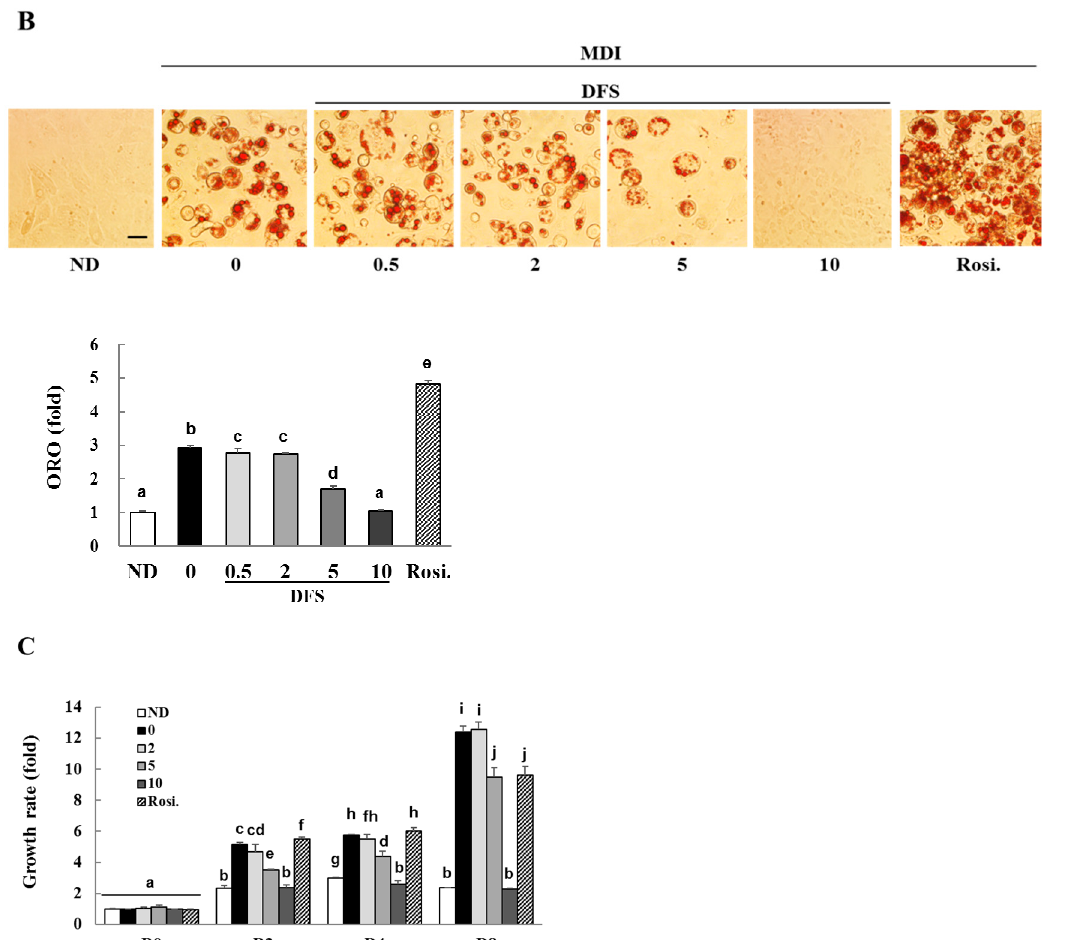
Figure 1. Lignan from A. japonica inhibits adipocyte growth and differentiation. ( A ) Structure of lignan (( − )-(2 R , 3 R )-1,4- O -diferuloylsecoisolariciresinol, DFS). ( B ) 3T3-L1 pre-adipocytes were differentiated with differentiation medium (MDI) in the presence or absence of DFS (0 ~ 10 µM). First, 3T3-L1 cells were stained with Oil Red-O (ORO) on D8 and intracellular lipid contents were quantified and visualized by light microscopy (magnification, ×40). Scale bar = 50 µm. ( C ) MTT assays were performed on differentiation day 0, 2, 4, or 8 (D0, D2, D4, or D8). Rosiglitazone (Rosi., 10 µM) was used as a positive control for adipogenesis. Data are means ± standard deviation (SD) of triplicate experiments. Means without a common superscript differ significantly ( p < 0.05).